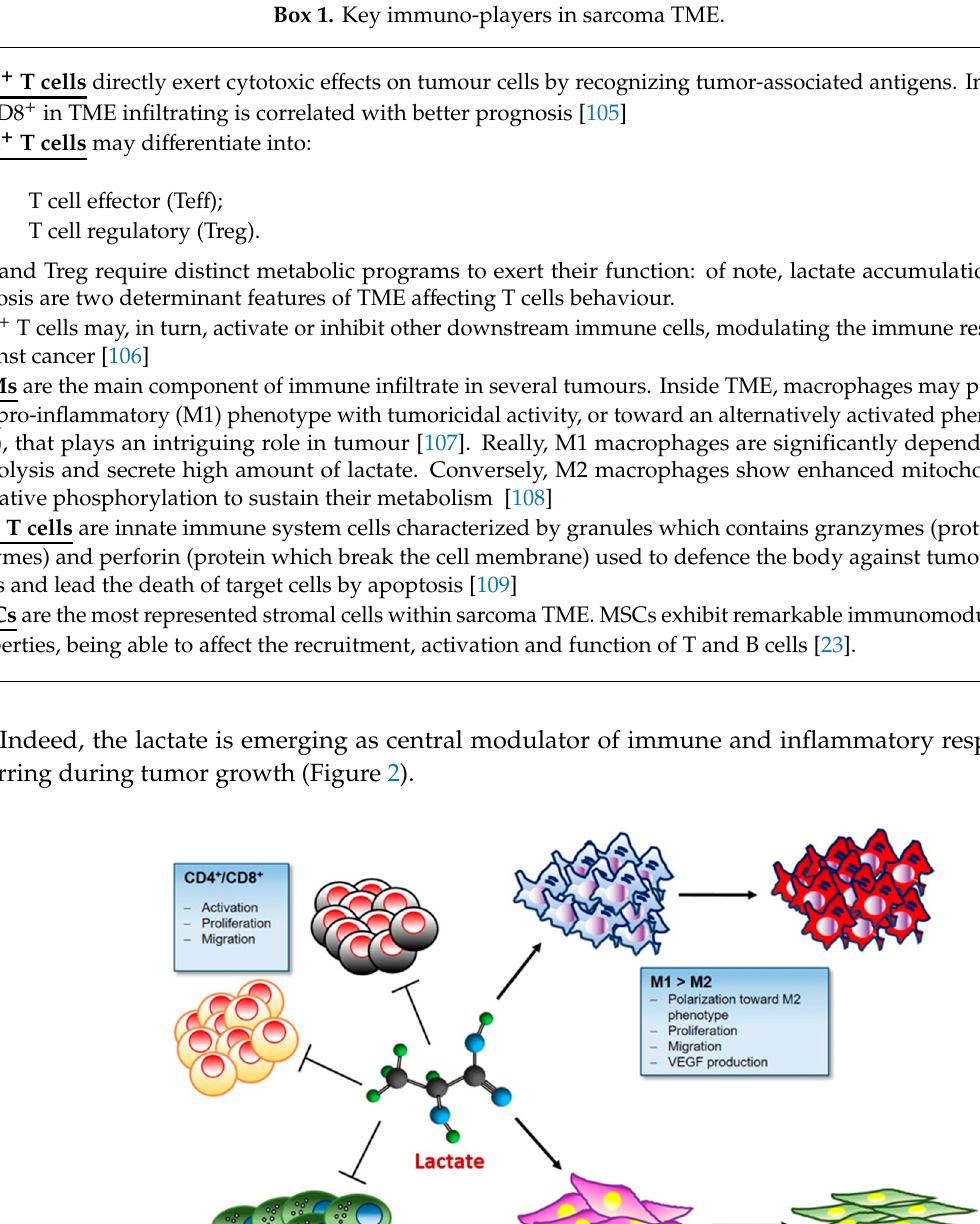
Box 1. Key immuno-players in sarcoma TME.